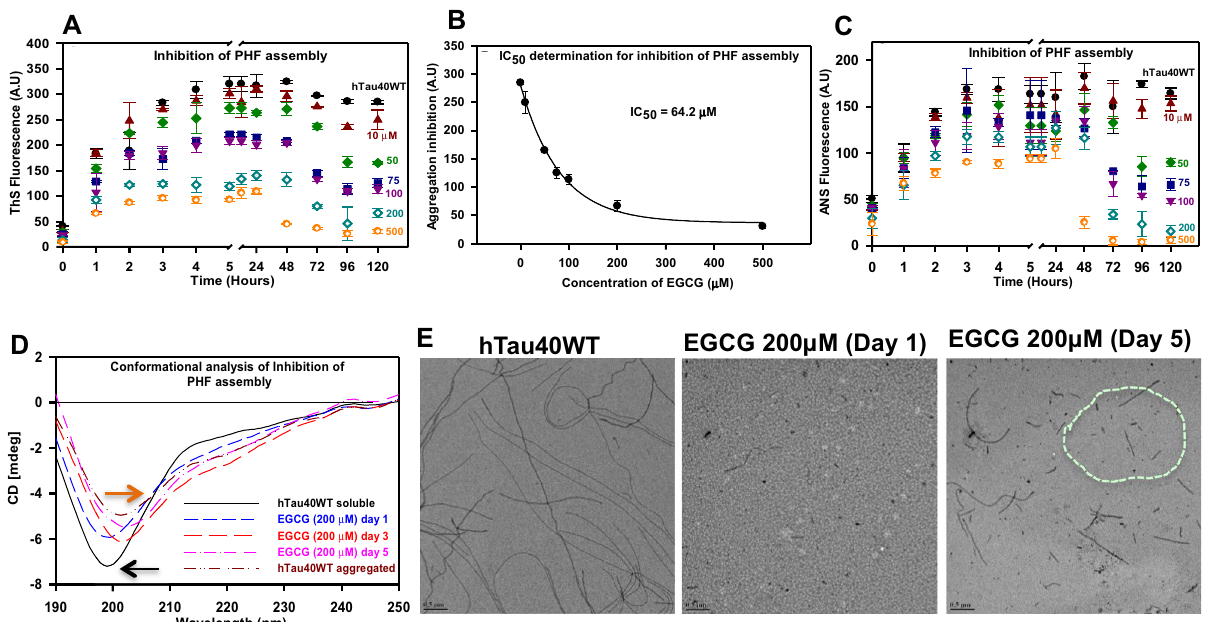
Figure 4. EGCG prevents Tau aggregation and changes their conformation in vitro. ( A ) The inhibitory effect of EGCG on the polymerization of full-length Tau monitored by ThS fluorescence. ( B ) The IC 50 for EGCG for full-length Tau is 64.2 μM. ( C ) The inhibition of Tau PHF assembly assessed by ANS fluorescence shows a time and dose dependent decrease in the hydrophobicity of the Tau protein. ( D ) The CD analysis of EGCG treatment shows the formation of mixed Tau structures in a time dependent manner. ( E ) The control reaction shows the presence of long mature filaments whereas the EGCG treatment shows increase in the fragility of the Tau filaments at with increasing in time. The 200 μM EGCG treatment shows broken filaments at the day 5 of